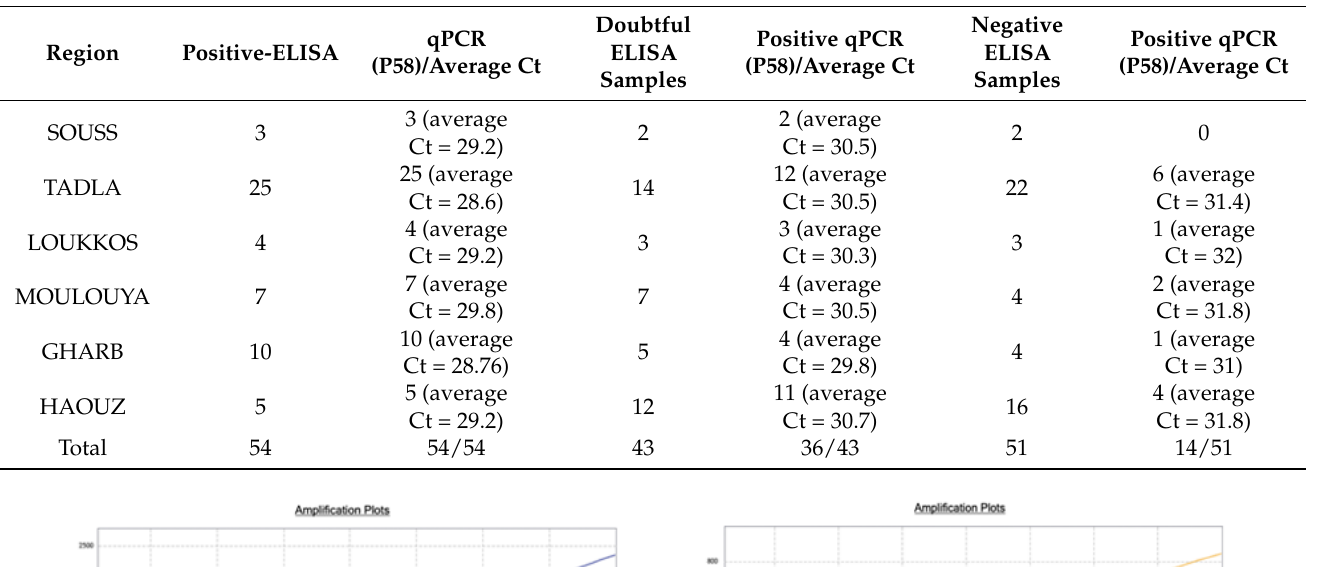
Table 2. Average Ct of qPCR positives by category of ELISA-positive samples. Number of Positive Samples